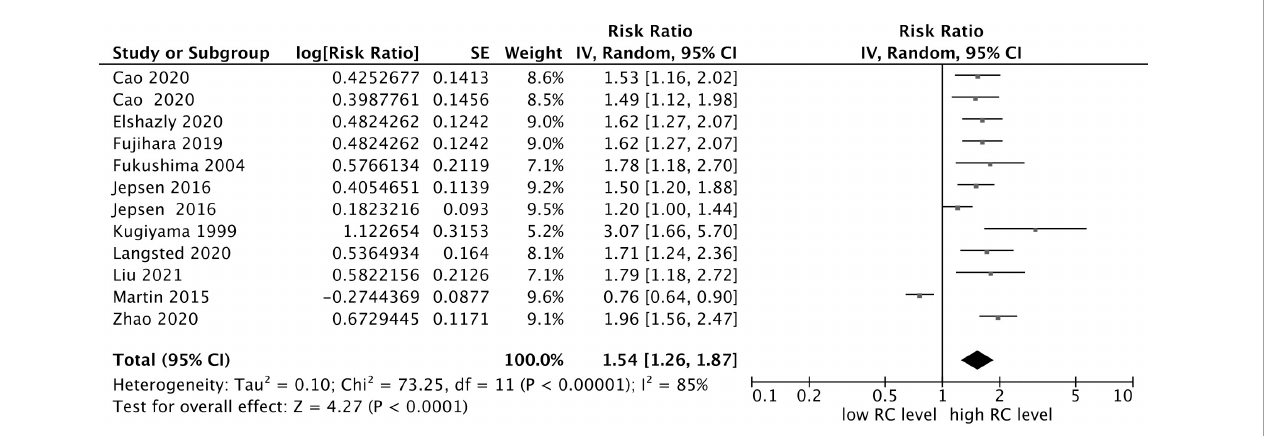
FIGURE2 Forest plots showing the pooled RR with 95% CI of composite endpoint events for the highest versus lowest remnant cholesterol concentration.